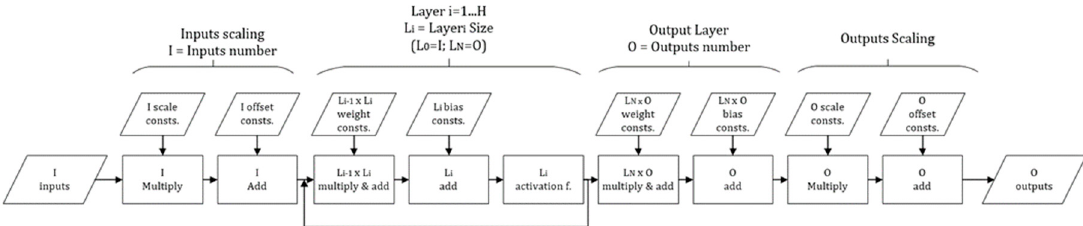
Figure 5. Flow chart of the generalized version of the implemented neural network inference algorithm, indicating the dimensions of the data and the amount of operation.